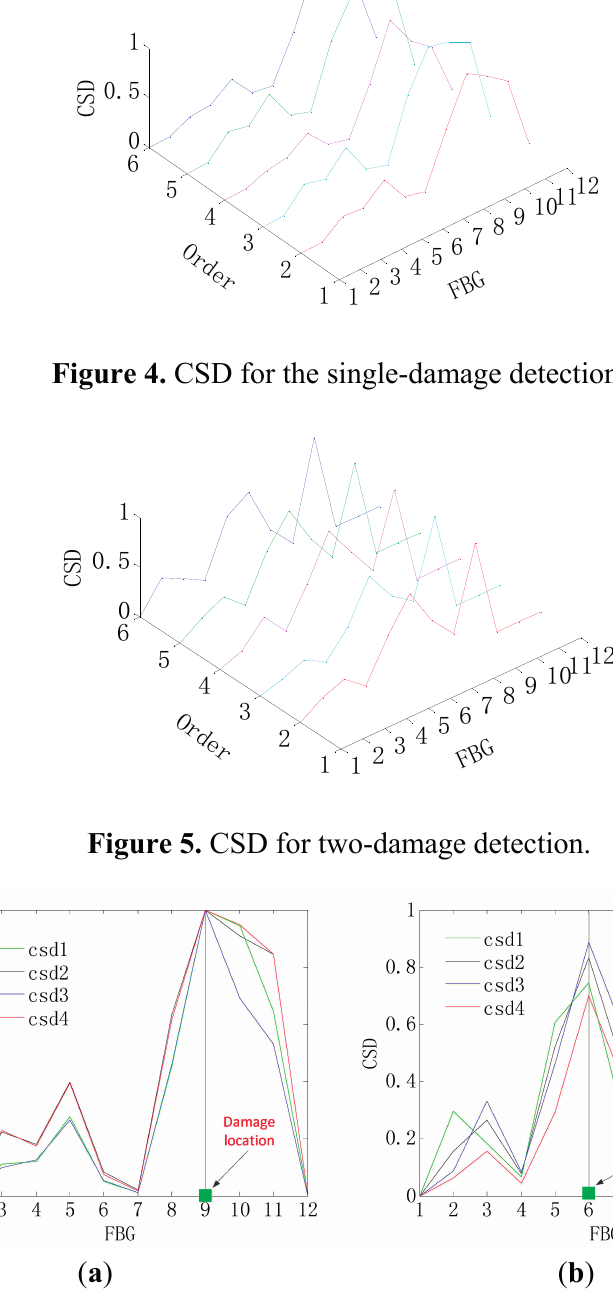
Figure 6. Method of detecting the damage location by the CSD. ( a ) The single-damage detection; ( b ) Two-damage